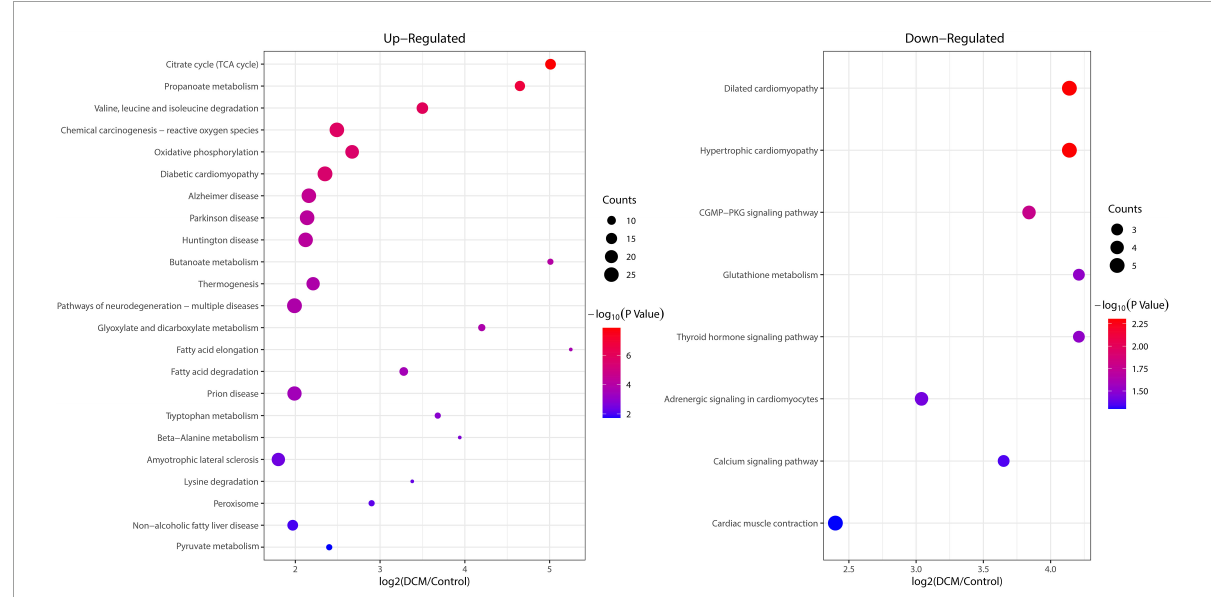
FIGURE6 Enrichment analysis of the lysine β -hydroxybutyrylation (kbhb) proteins in heart tissue of diabetic cardiomyopathy (DCM) rats according to the Kyoto Encyclopedia of Genes and Genomes (KEGG) pathway. (left) Upregulated. (right)